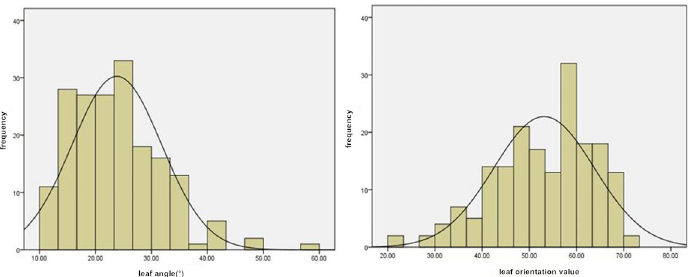
Fig 2. Distribution of leaf angle and leaf orientation value phenotypes in the biparental mapping